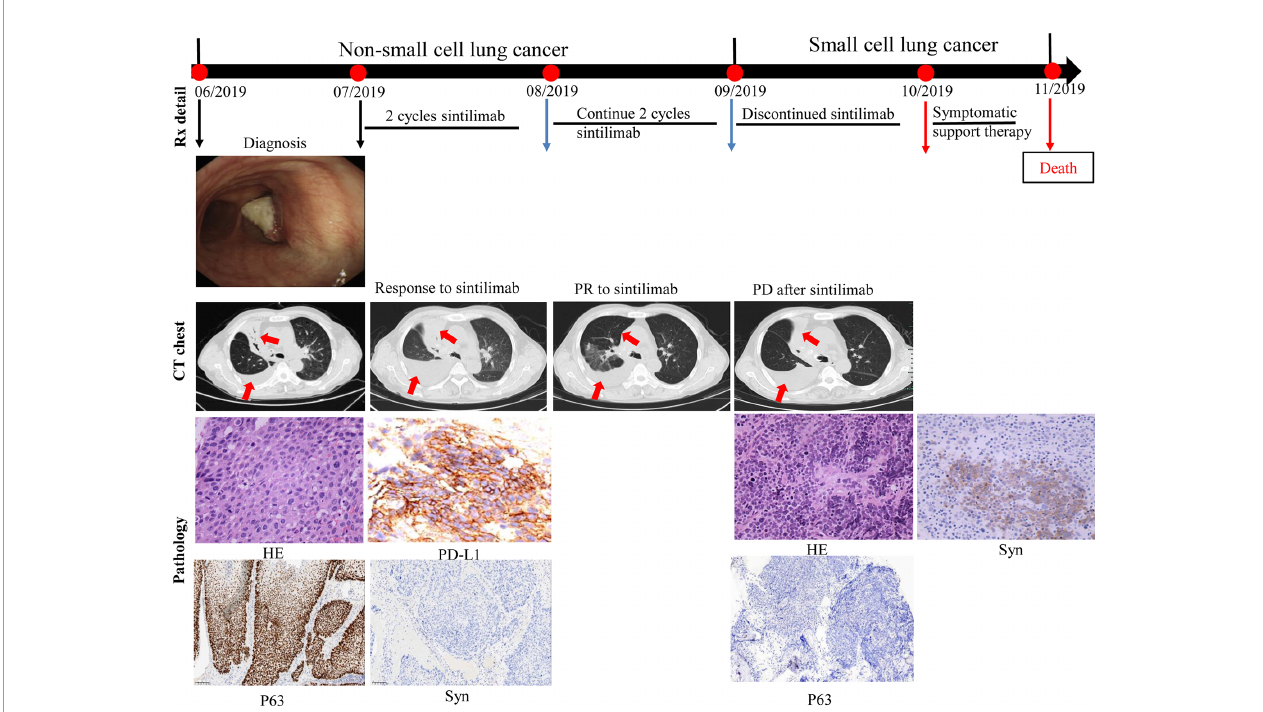
FIGURE 1 | Case presentation of transformation of lung squamous cell carcinoma to small cell lung carcinoma with fi rst-line sintilimab monotherapy. CT, computed tomography; HE, Hematoxylin and Eosin; Syn, synaptophysin; Rx,